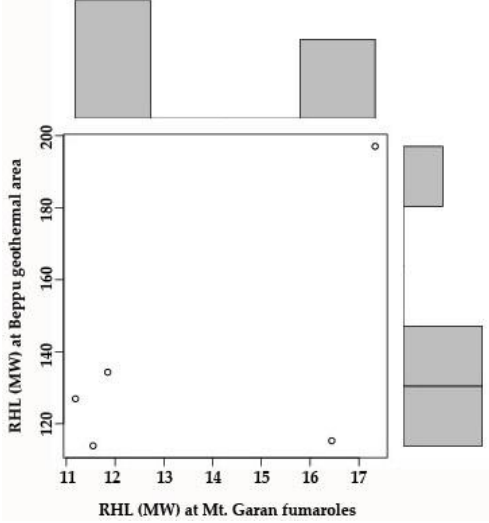
Figure 22. Scatter plots and histogram of RHL between Mt. Garan fumaroles and Beppu geothermal area.